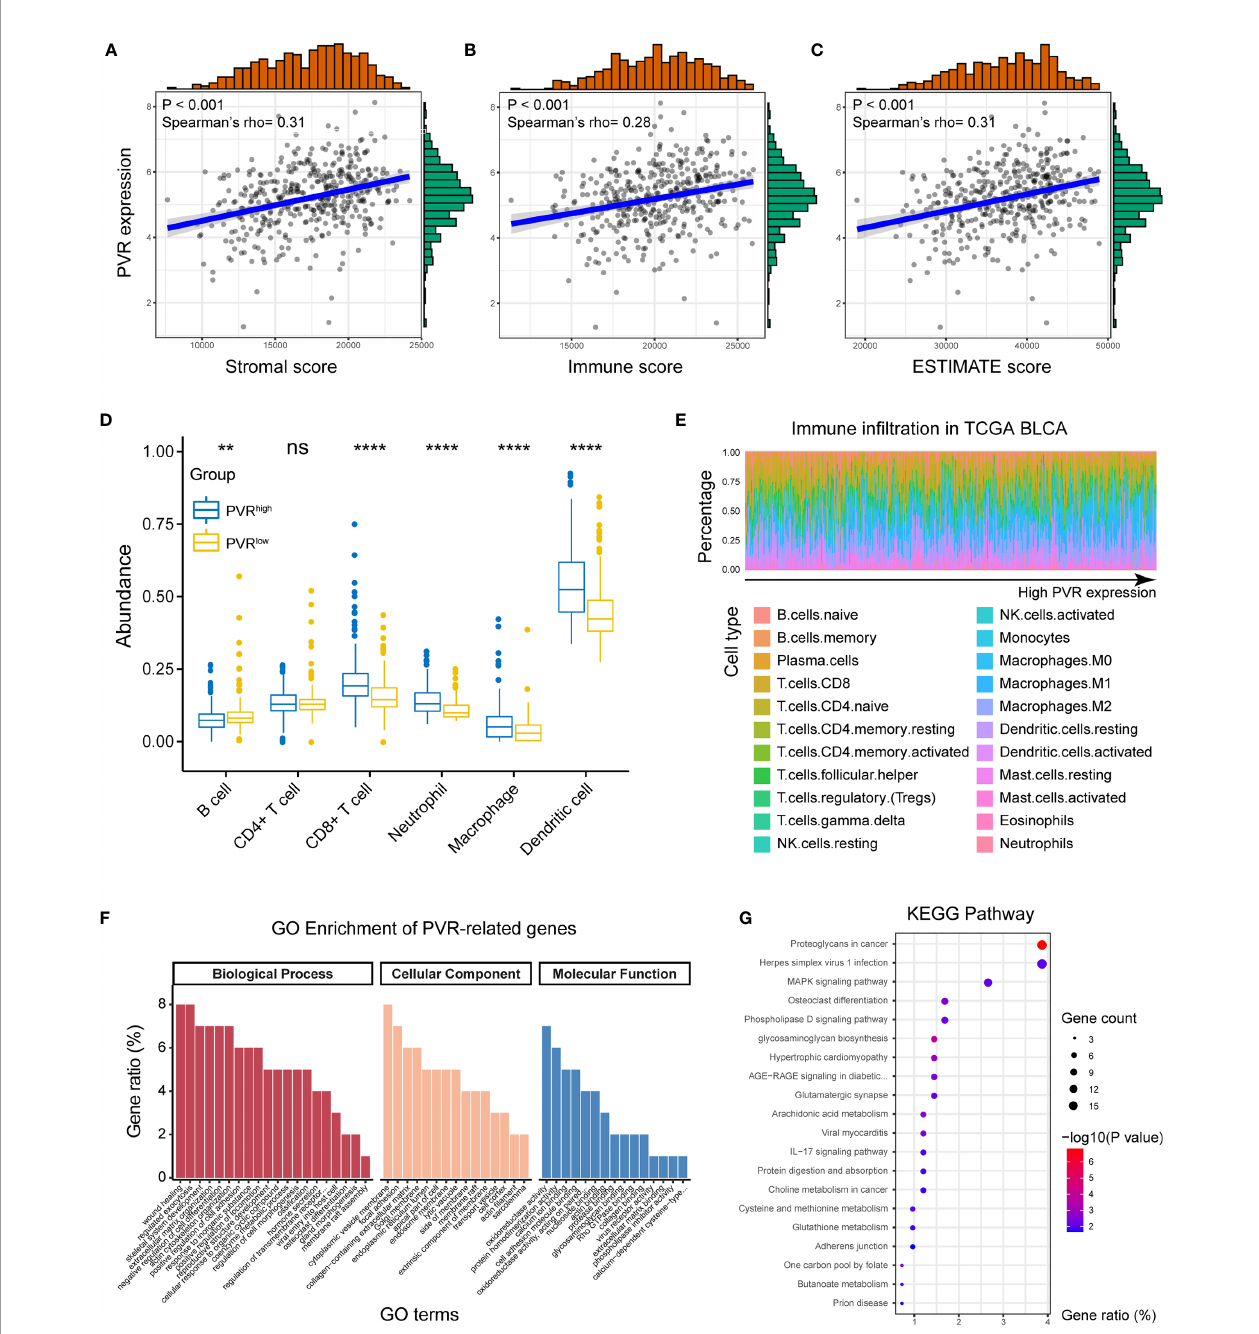
FIGURE 3 | PVR correlating with tumor purity, immune in fi ltration, and immune-oncologic pathways. (A – C) PVR expression correlates with stromal, immune, and ESTIMATE scores, respectively in TCGA BLCA cohort. (D) The abundance of 6 immune in fi ltrates between PVR high and PVR low groups in TCGA BLCA cohort (based on TIMER algorithm). (E) The abundance of 22 immune in fi ltrates in TCGA BLCA cohort (based on CIBERSORT algorithm). (F, G) GO and KEGG analysis of PVR - related genes in bladder cancer. **P < .01, ****P < .0001. ns, not signi fi